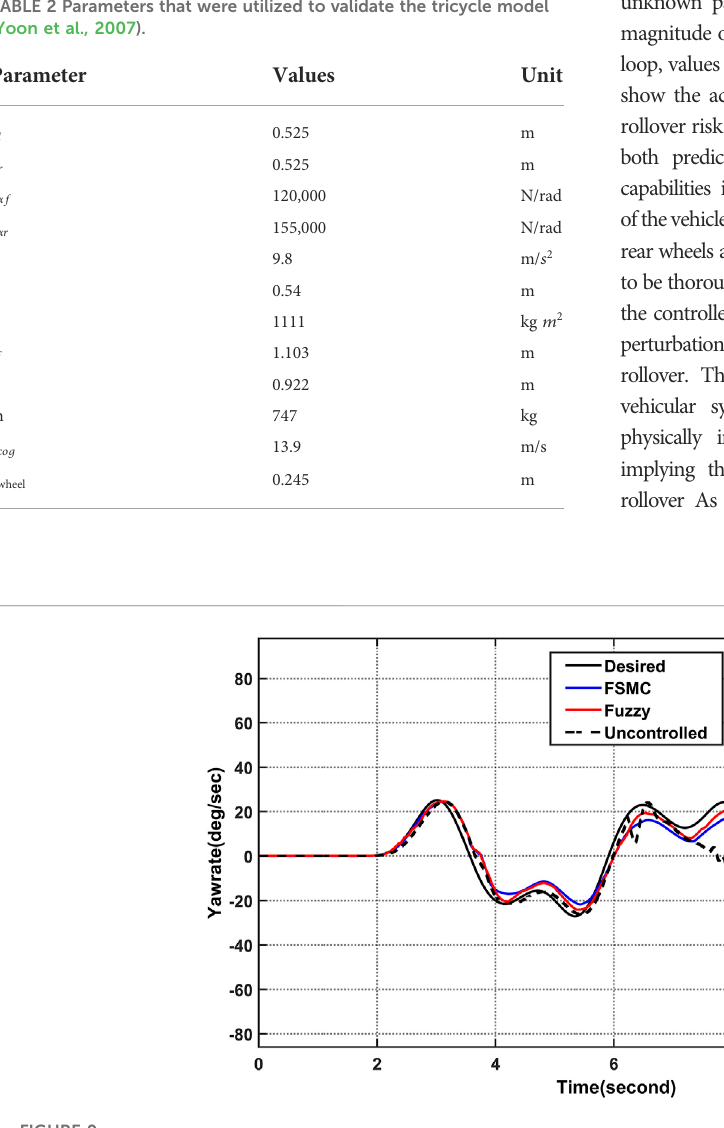
FIGURE 9 Simulation results comparison of yaw rate ( γ ) value of maneuver of 180% amplitude increment at 50